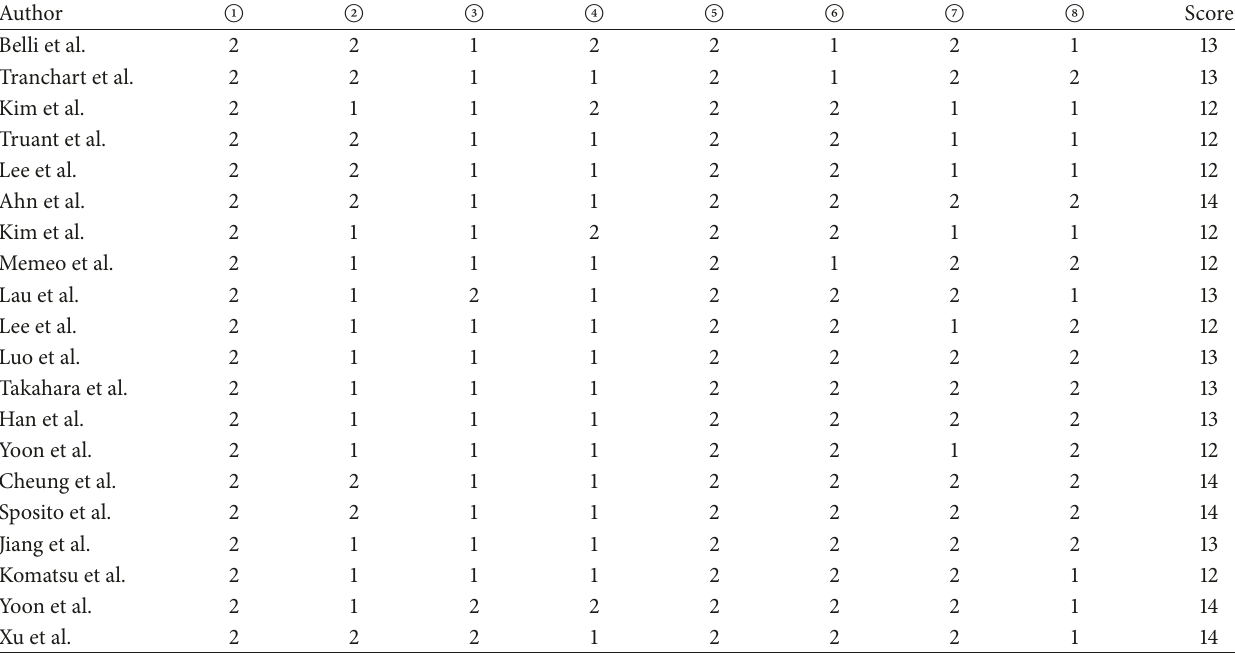
Table 2: Modified MINORS score of all eligible nonrandomized comparative